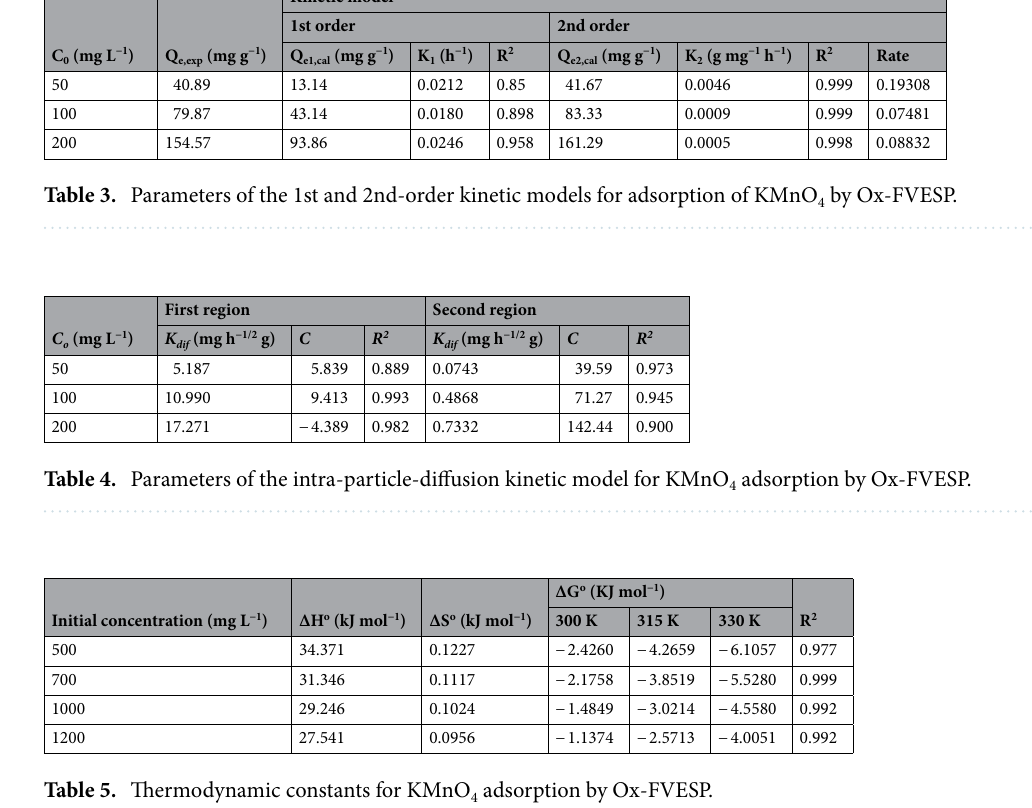
Table 5. Thermodynamic constants for KMnO 4 adsorption by Ox-FVESP.